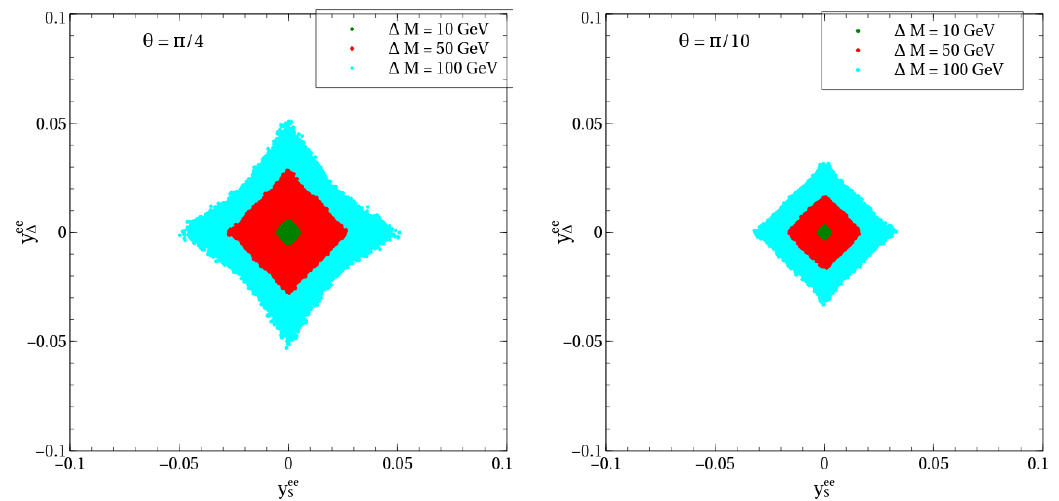
Figure 2 . The allowed parameter space maintaining (cid:1) a (cid:22) within its 2 (cid:27) range in the y (cid:22)(cid:28) plane for (cid:18) = (cid:25) (left) and (cid:25) (right). The color coding is explained in the legends. 4 10